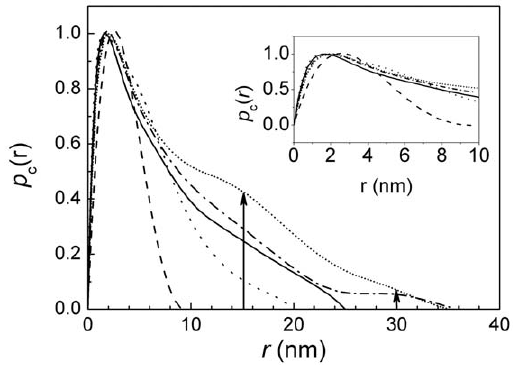
Figure 10. Pair distance distribution function of PfnM-deco- rated ActM polymers. Cross section pair distribution functions of rabbit F-actin (dashed line), polymerized ActM (dotted) and polymer- ized ActM with PfnM in molar ratios of 2:1, 1:1 and 1:2 (solid, dash- dotted, shot dotted line, respectively). Maximum dimensions at p c ( r ) =0 are at 9 nm, 20 nm, 25 nm and 35 nm. Inset: Magnification of the region around the maxima of the p c ( r ).